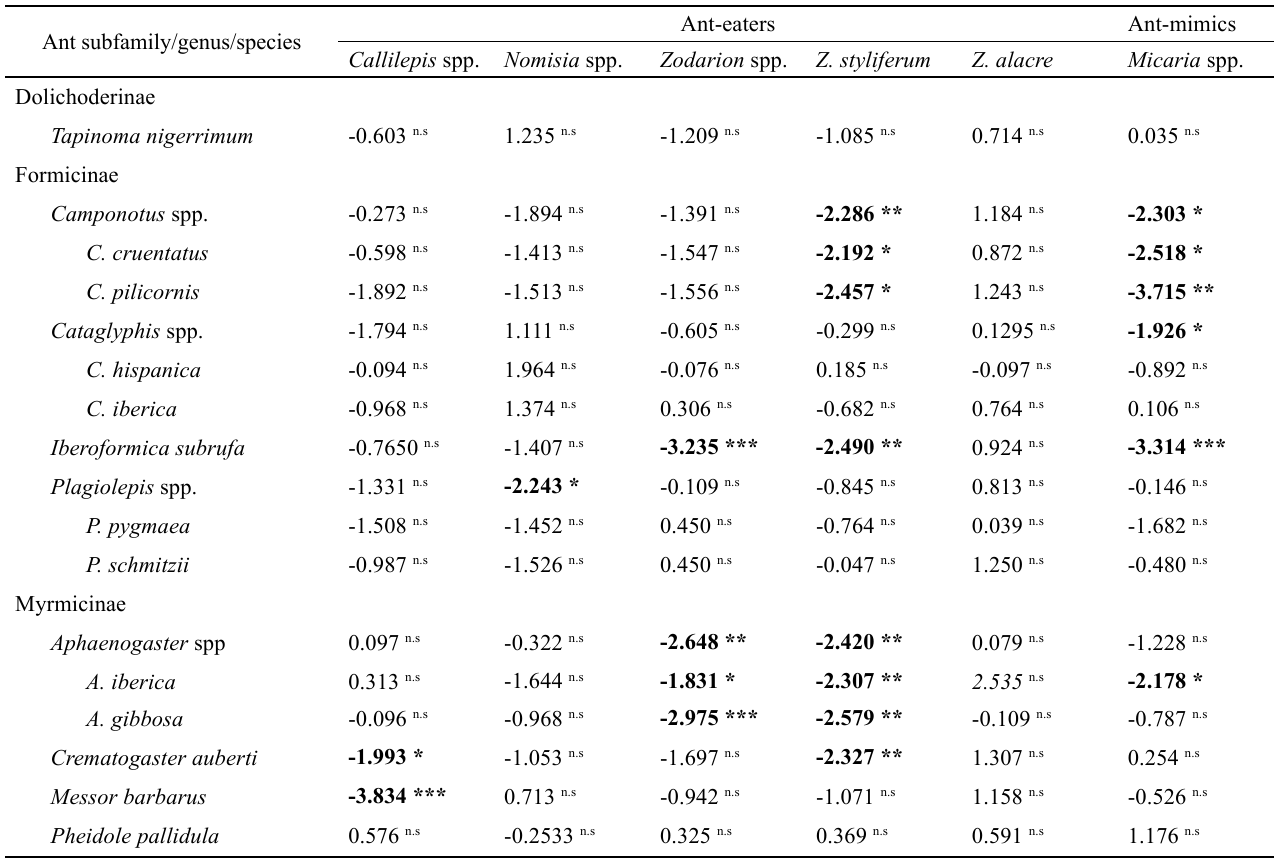
Table 3. Standard effect size (SES) for the co-occurrence of ant associated spiders and ants (genera and species) in null model tests. Significant values are reported in bold. The significance level of p <0.05 is reported for the number of samples for which the observed value of the index was significantly less than the expected by chance (O<E). Only genera /species with at least five occurrences were included in the analysis